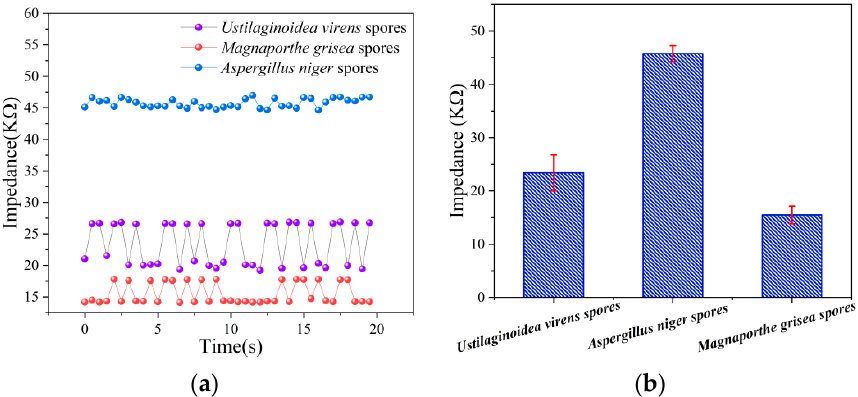
Figure 10. The curve of three kinds of spore impedance with time ( a ) Variation of impedance of three spores with time at 80 KHz ( b ) The impedance changes of the three spores at 80 KHz, the values shown represent the average of 10 experimental measurements for each spore.